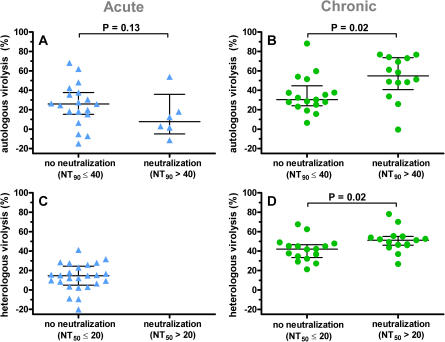
Neutralizing Antibodies Are Not the Major Constituent of Complement Lysis-Inducing AntibodiesComplement lysis activity of non-neutralizing and neutralizing patient plasmas was compared in the acute and the chronic infection cohorts. Autologous neutralization (A and B) and heterologous (JR-FL) (C and D) neutralization are shown, with blue triangles denoting acutely, green circles chronically infected patients. Each data point represents the mean of two or three independent experiments with plasma from the same patient. Groups were compared using Mann-Whitney U test.